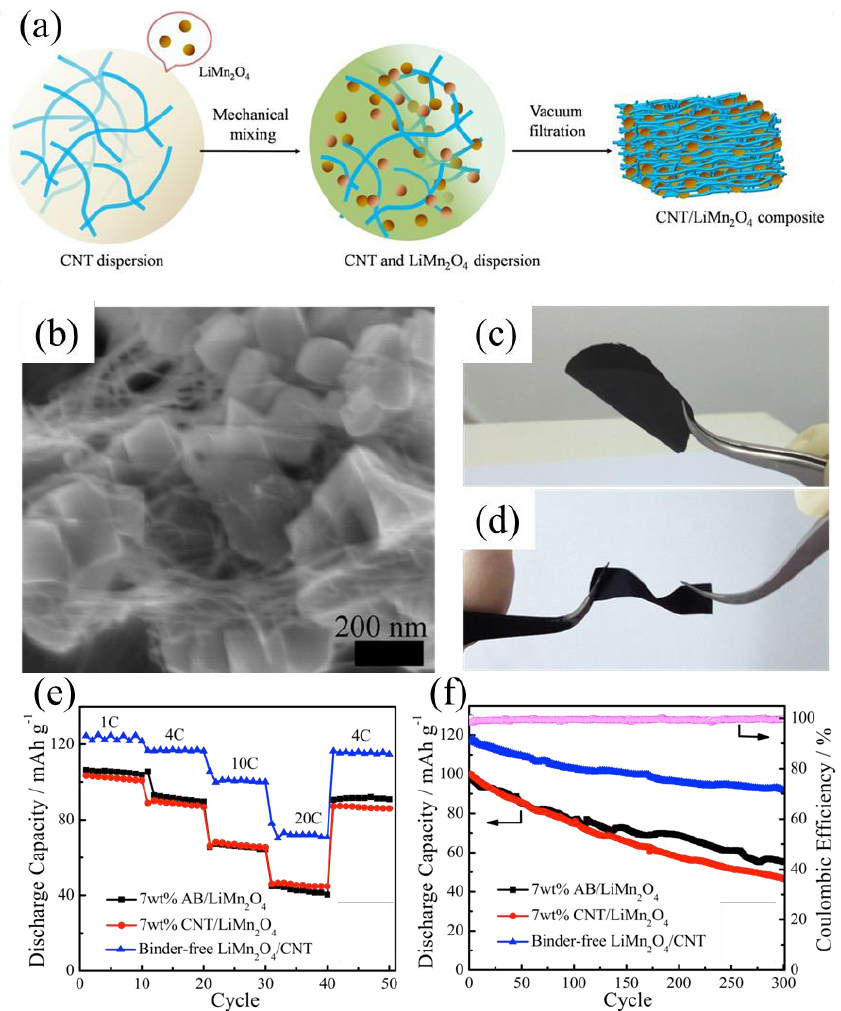
Figure 7. ( a ) Schematic fabrication of binder-free flexible LiMn 2 O 4 /CNT network electrodes through dispersion and vacuum filtration processes; ( b ) SEM image of the binder-free flexible LiMn 2 O 4 /CNT electrode; optical photographs of the produced hybrid film under: ( c ) bending; and ( d ) twisting; and comparison of: ( e ) rate; and ( f ) cycling performance of the binder-free LiMn 2 O 4 /CNT, 7 wt % CNT/LiMn 2 O 4 , and 7 wt % AB/LiMn 2 O 4 electrodes (modified from Ref. [69] with permission from